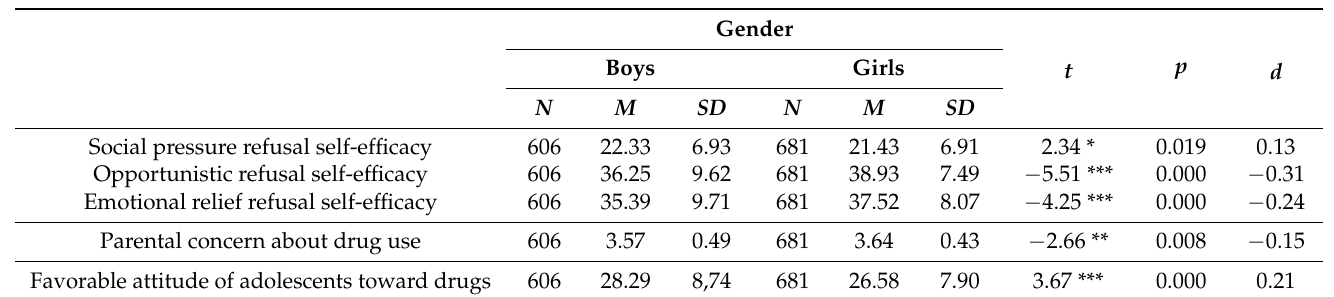
Table 3. Self-efficacy in refusing alcohol, parents’ attitude toward drugs and favorable attitude toward drugs. Descriptive statistics and t-test by gender.